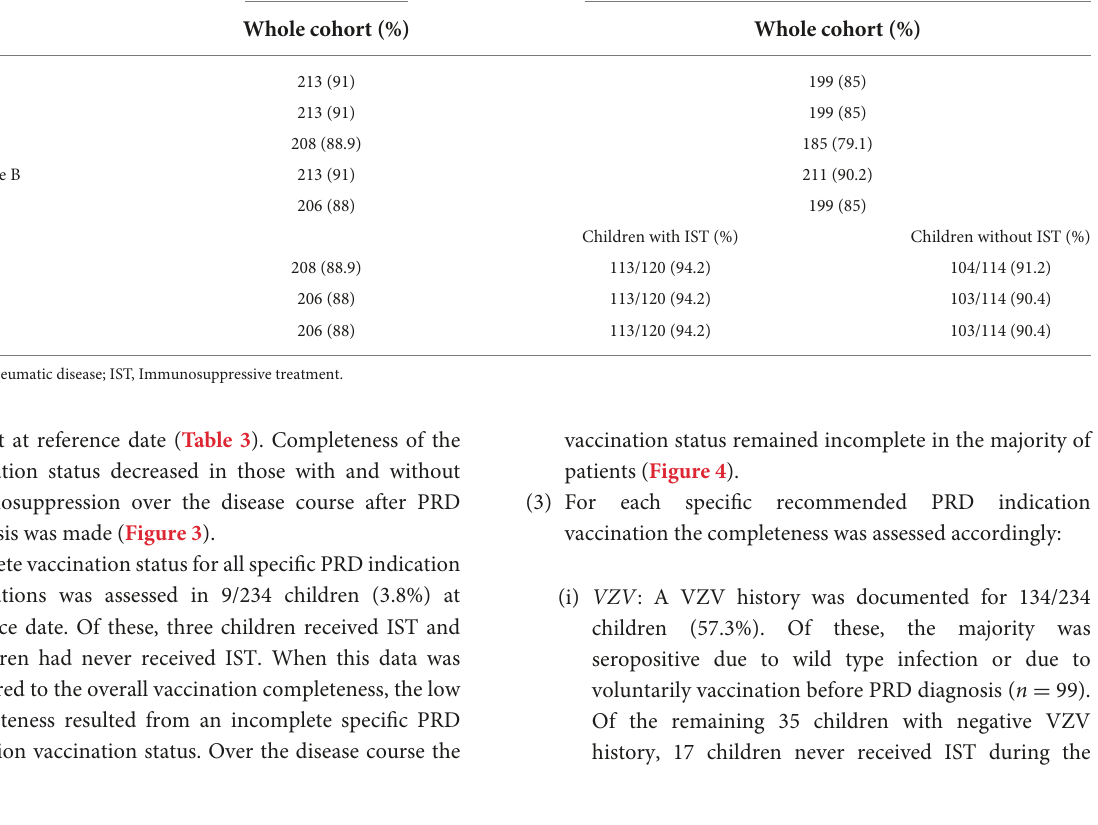
TABLE 3 Vaccination status in children with PRD according to the Swiss national vaccination schedule. Vaccination